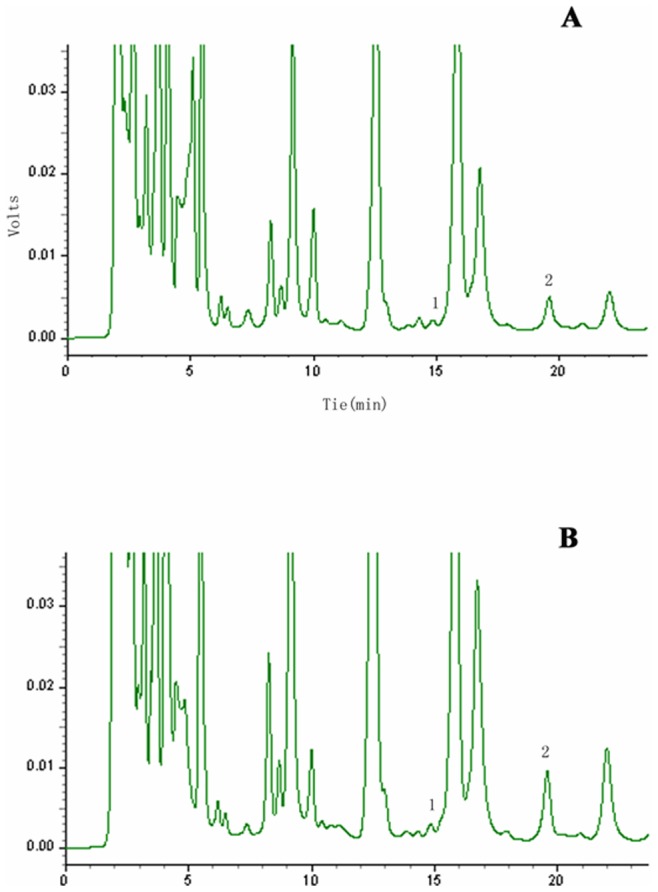
Chromatogram of HPLC for L-citrulline and L-arginine in colorectal tissues.The upper panel (a) shows the result from paired adjacent normal sigmoid flexure tissue in a patient with sigmoid colon cancer. The lower panel (b) shows the result from sigmoid flexure cancer tissue in the same patient. The individual marked peaks (1) and (2) represent L-citrulline and L-arginine respectively.